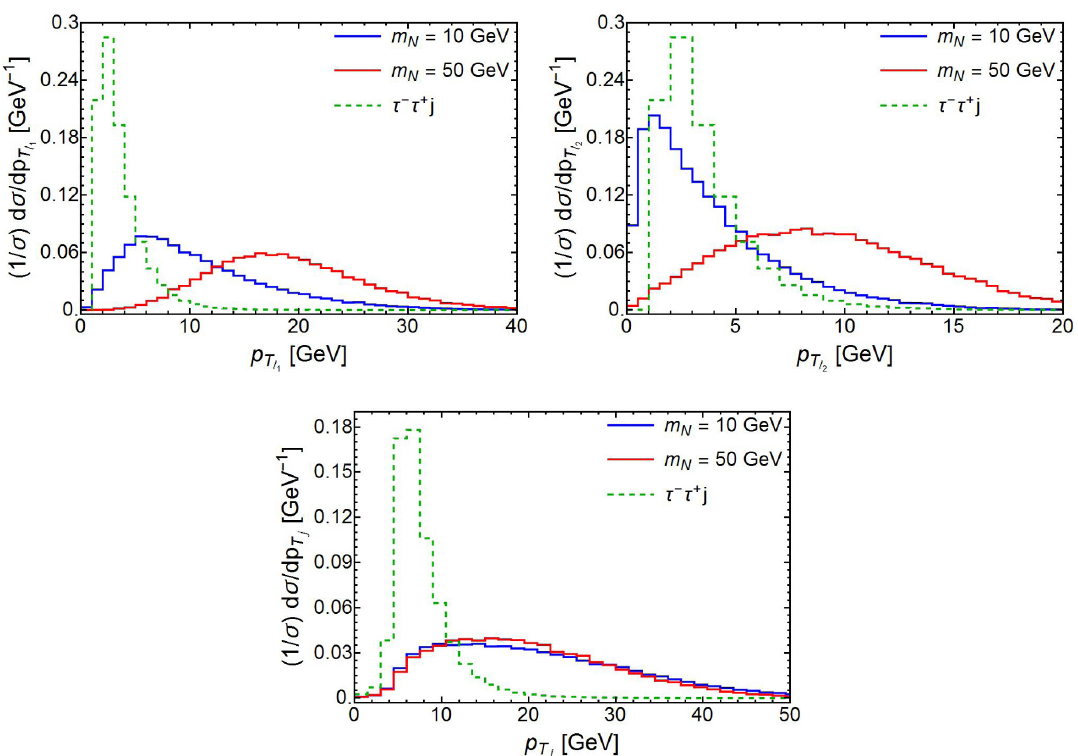
Figure 6 . Transverse momentum distributions of leptons and the jet for signals with m N = 10 and 50 GeV and the τ + τ − j background in the e + µ − j + E miss eqs.